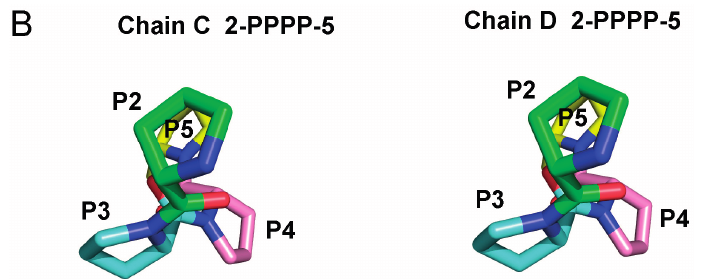
Figure 3. ( A ) Stick models of chains C and D are superposed with an electron density map shown in mesh. In the stick model, carbon atoms are shown in light green in chain C and in cyan in chain D, and nitrogen, oxygen and sulfur atoms are shown in blue, red and yellow, respectively, in both chains; ( B ) Left-handed type II polyproline (PPII) helices are formed in the Pro-clustered segments ( 2 PPPP 5 ) in chains C and D. Pro residues are highlighted in different colors as indicated (from green, cyan, pink to yellow, in